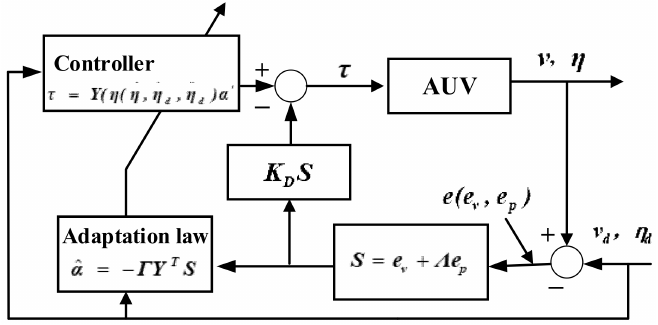
Figure 8. Structure of the adaptation control